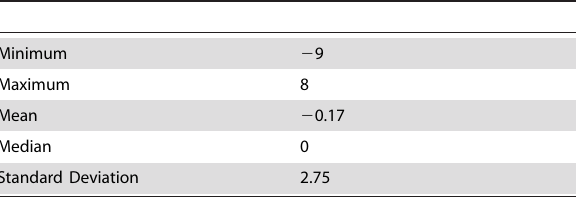
Table 5. Summary statistics of the total score of the